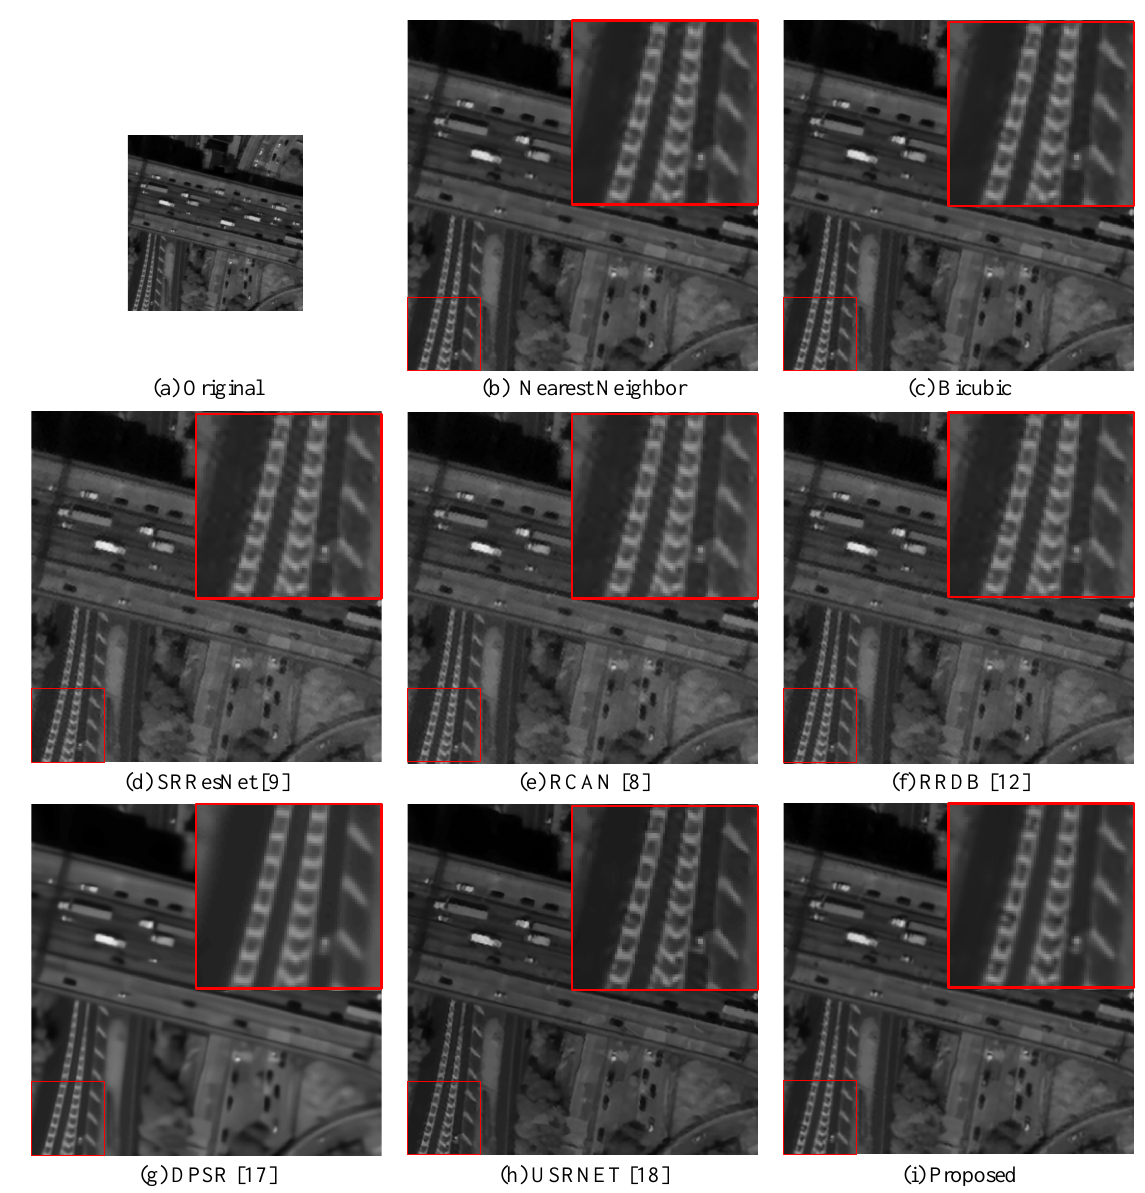
Figure 8. Visual qualitative comparisons of the proposed method with other SR methods on a panchromatic image, Henry Hudson Parkway,